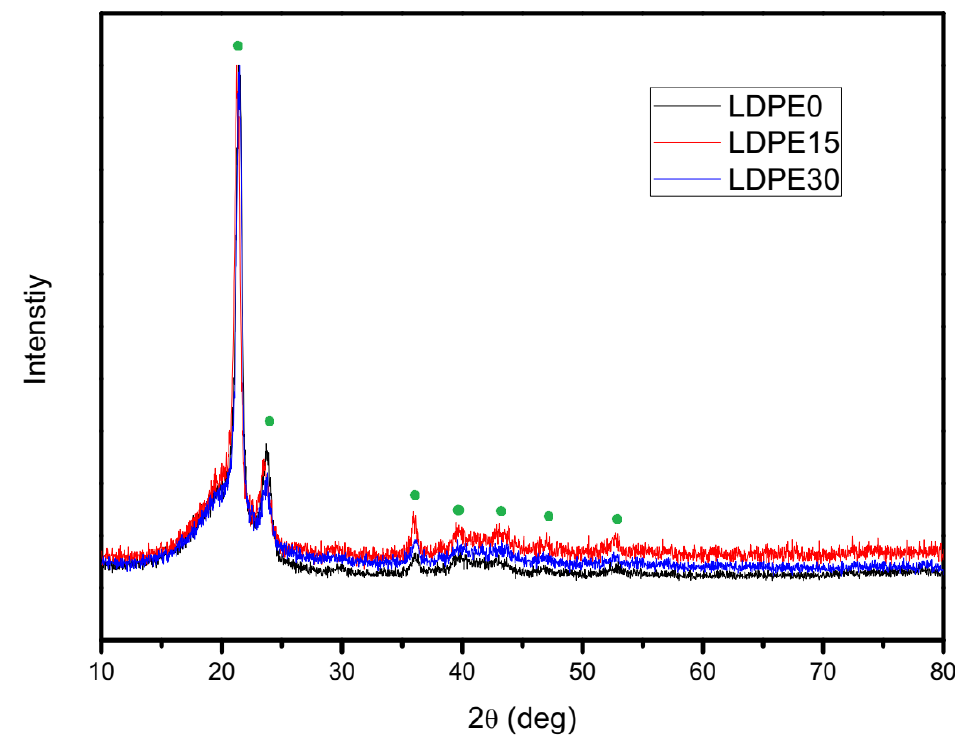
Figure 7. X-ray di ff raction plot of neat LDPE and the obtained Figure 7. X-ray diffraction plot of neat LDPE and the obtained composites. Figure 7. X-ray diffraction plot of neat LDPE and the obtained composites.